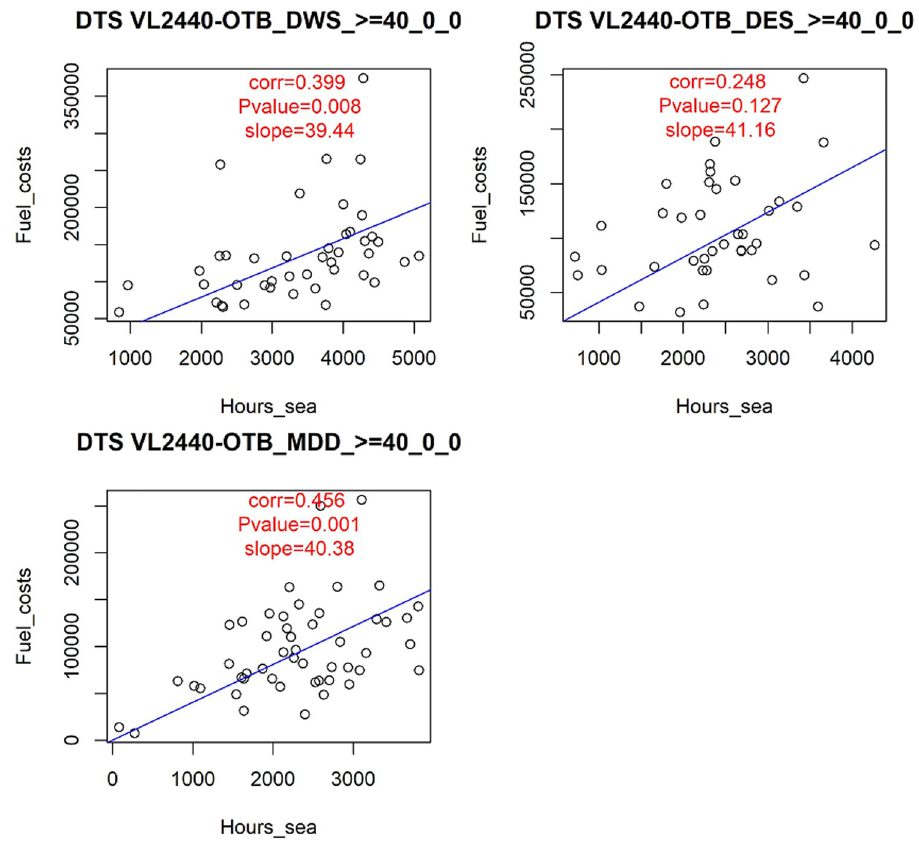
Fig 4. Linear correlations between fuel costs and hours at sea across the me´tier of DTS